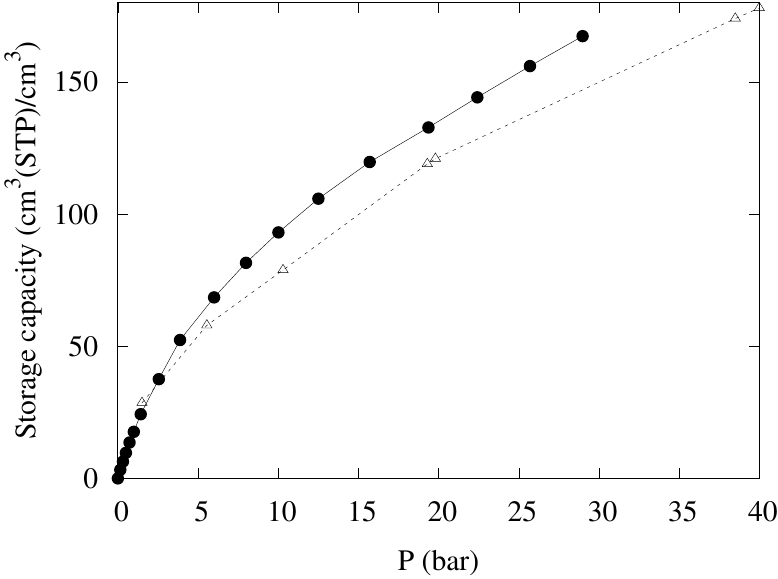
Figure 10. Storage density at 298 K for CH 4 in KPS-1 (solid circles) and LMA738 (open triangles)